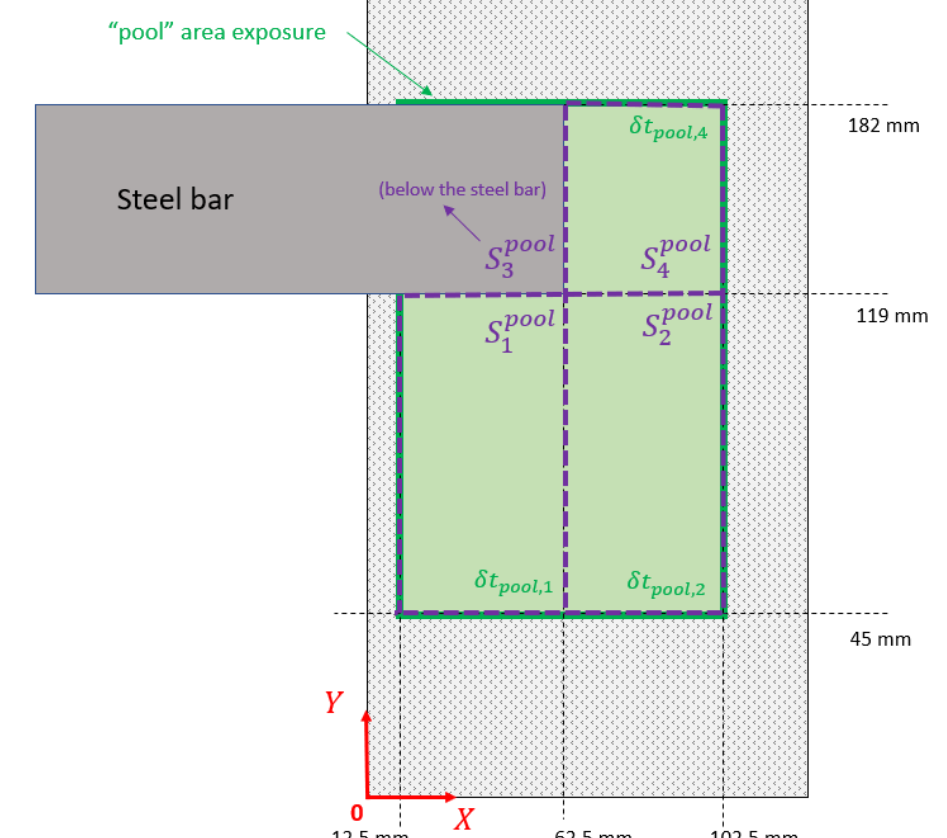
Figure 7. Subzones of the “pool” surface. Table 4. Exposure time δ t pool,k according to the subzone S pool